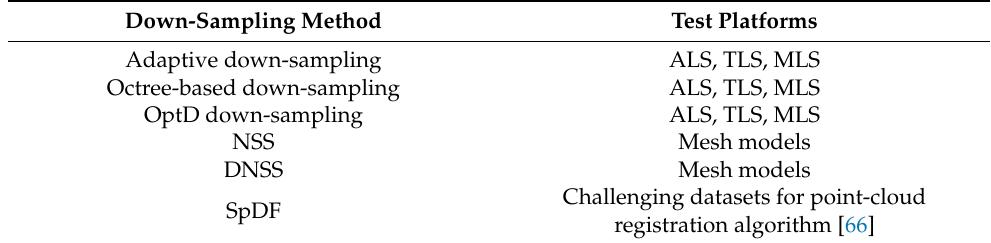
Table 4. Point-cloud down-sampling